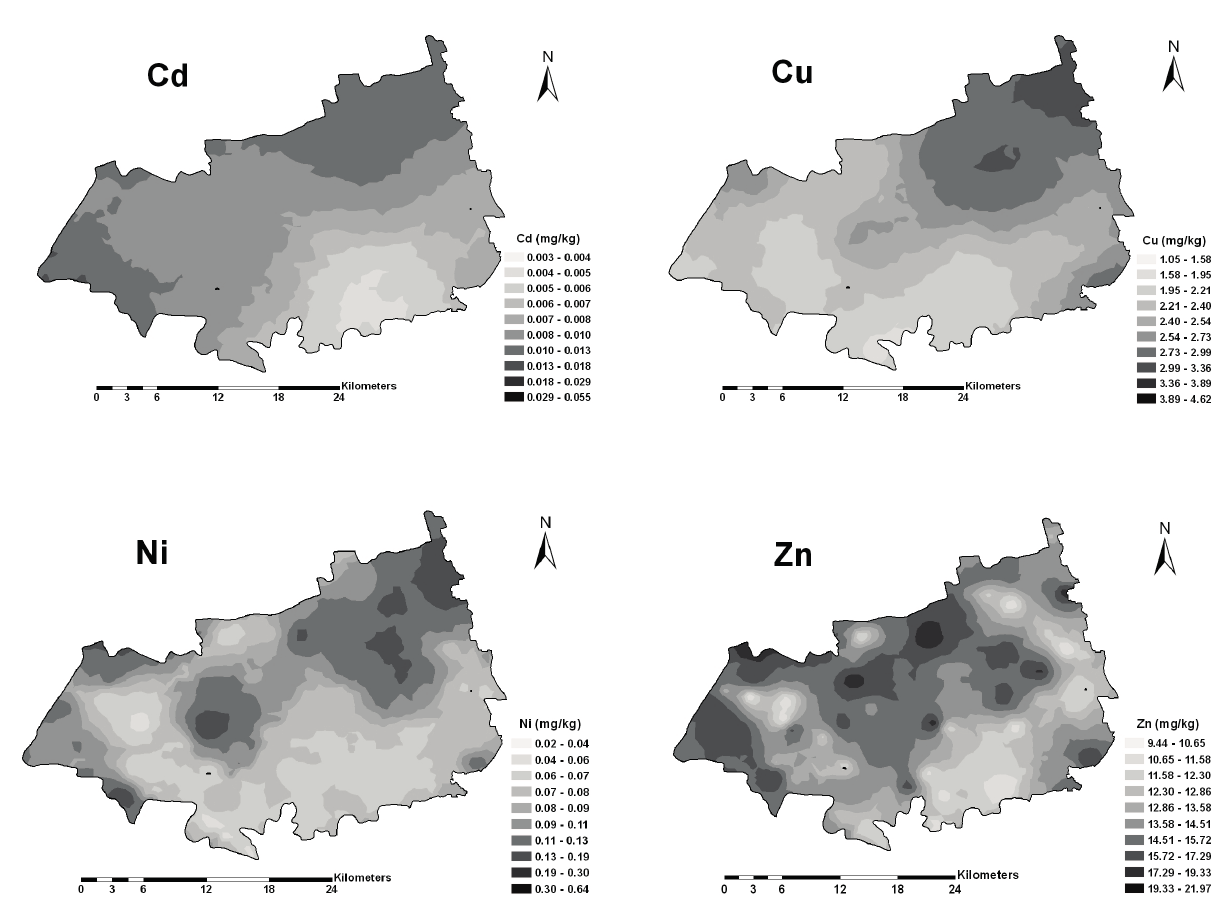
Figure 4. Spatial distribution maps of heavy metals in rice.